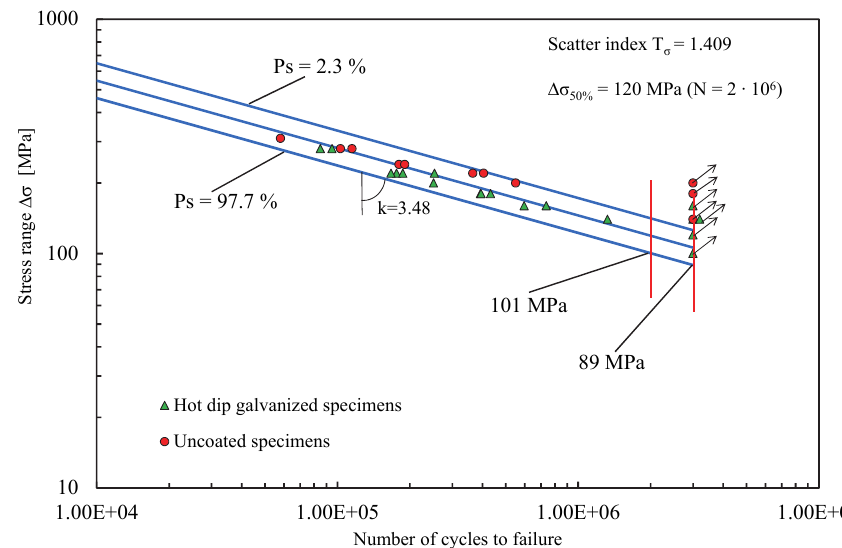
Figure 8: Unified scatterband considering uncoated and hot dip galvanized